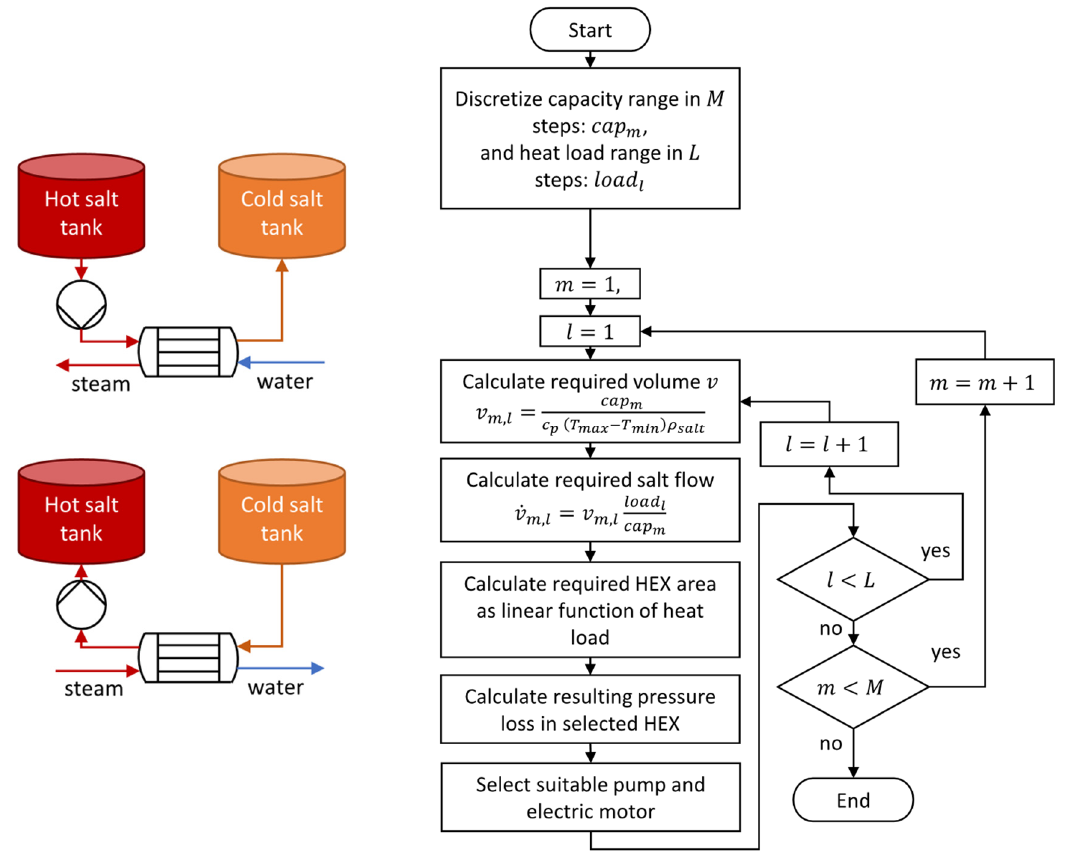
Figure 7. Sketch of the molten salt TES system in charging and discharging modes ( left ) and calculation of storage parameters and selection of pumps and motors for molten salt storage ( right ).